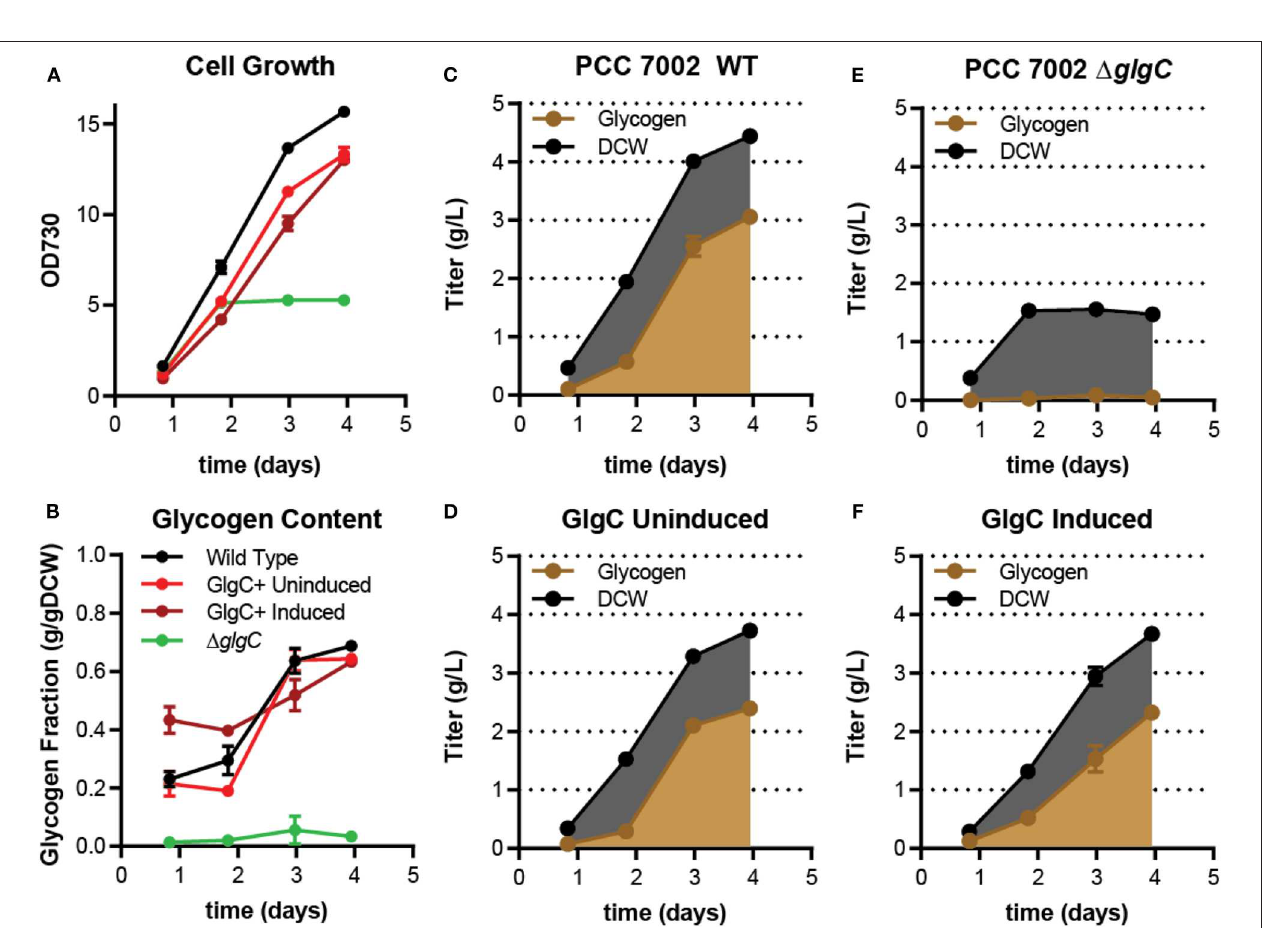
FIGURE 2 | Biomass and glycogen production by PCC 7002 strains under continuous light conditions in media A. (A) Shows the biomass production measured by optical density at 730nm. (B) Reports the fraction of the total dry cell weight that was glycogen over time. (C–F) Show the titer of glycogen (brown) and total DCW (black) over time for each of the four listed cultures. The difference between the DCW and glycogen content represents the productive biomass. Each culture was performed in triplicate. Error bars represent standard deviation.